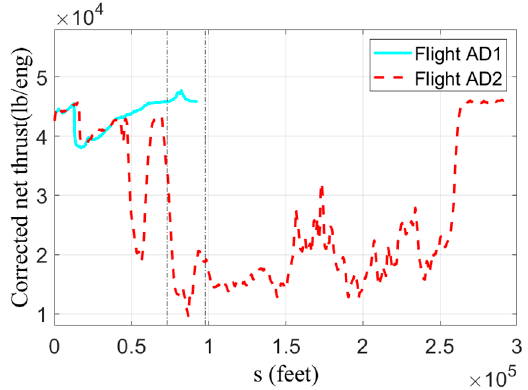
Figure 12. Power settings (engine thrust) evolution of flights AD1 and AD2.